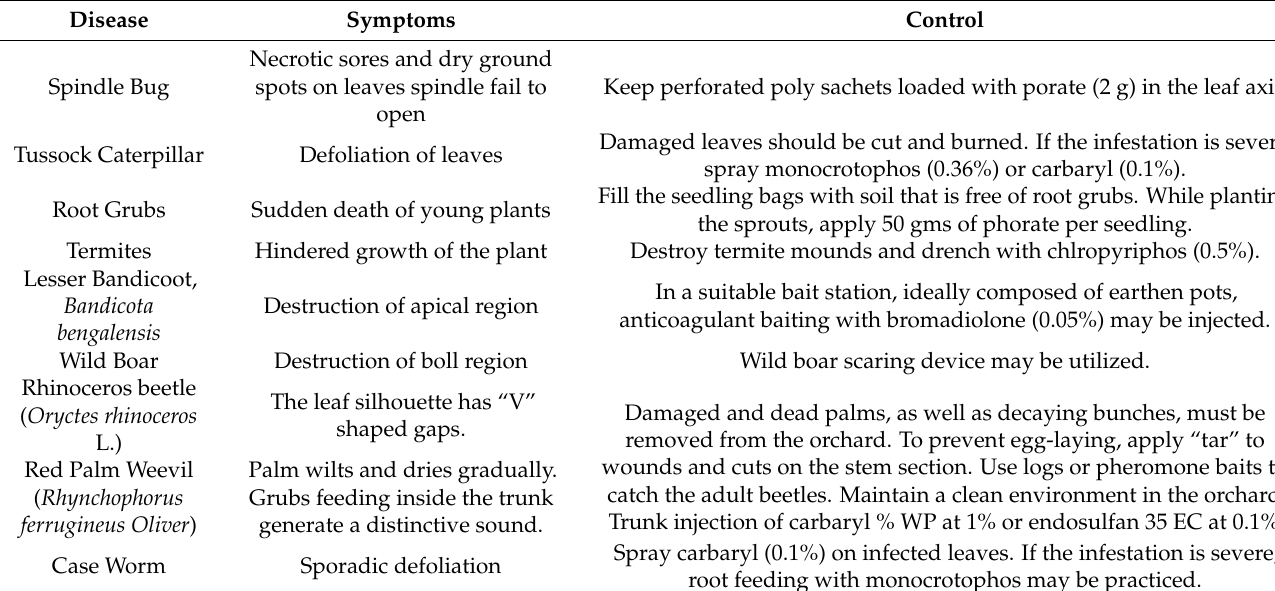
Table 2. Common pests and diseases of oil palm and